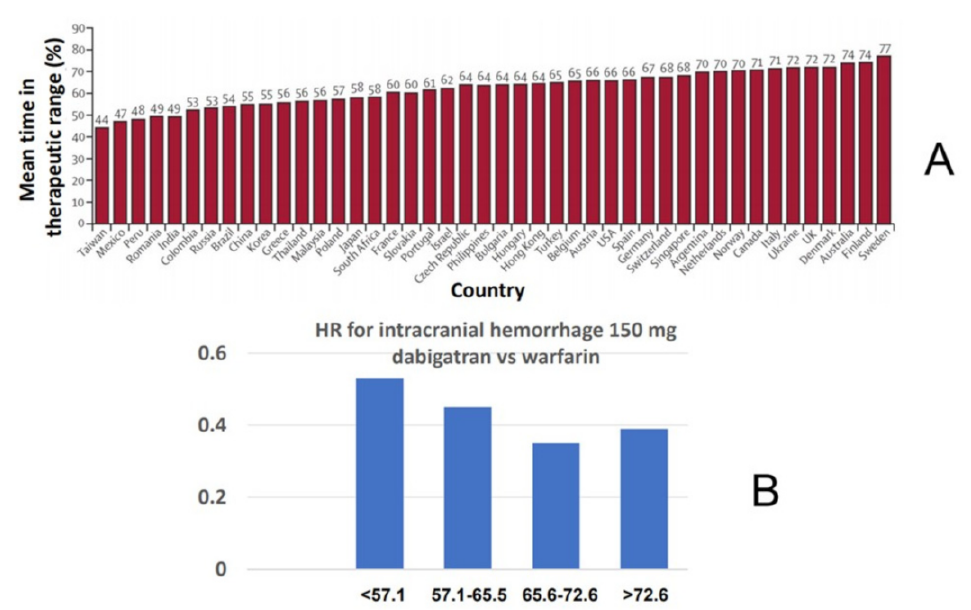
Figure 3. Relative risk of intracranial hemorrhage for dabigatran vs. warfarin as a function of time in therapeutic range (cTTR) of centers participating in the RE-LY trial. ( A ) Distribution of mean cTTR in countries participating in the trial. ( B ) Hazard ratios (HR) for intracranial hemorrhage in the comparison of dabigatran 150 mg twice daily vs. warfarin as a function of